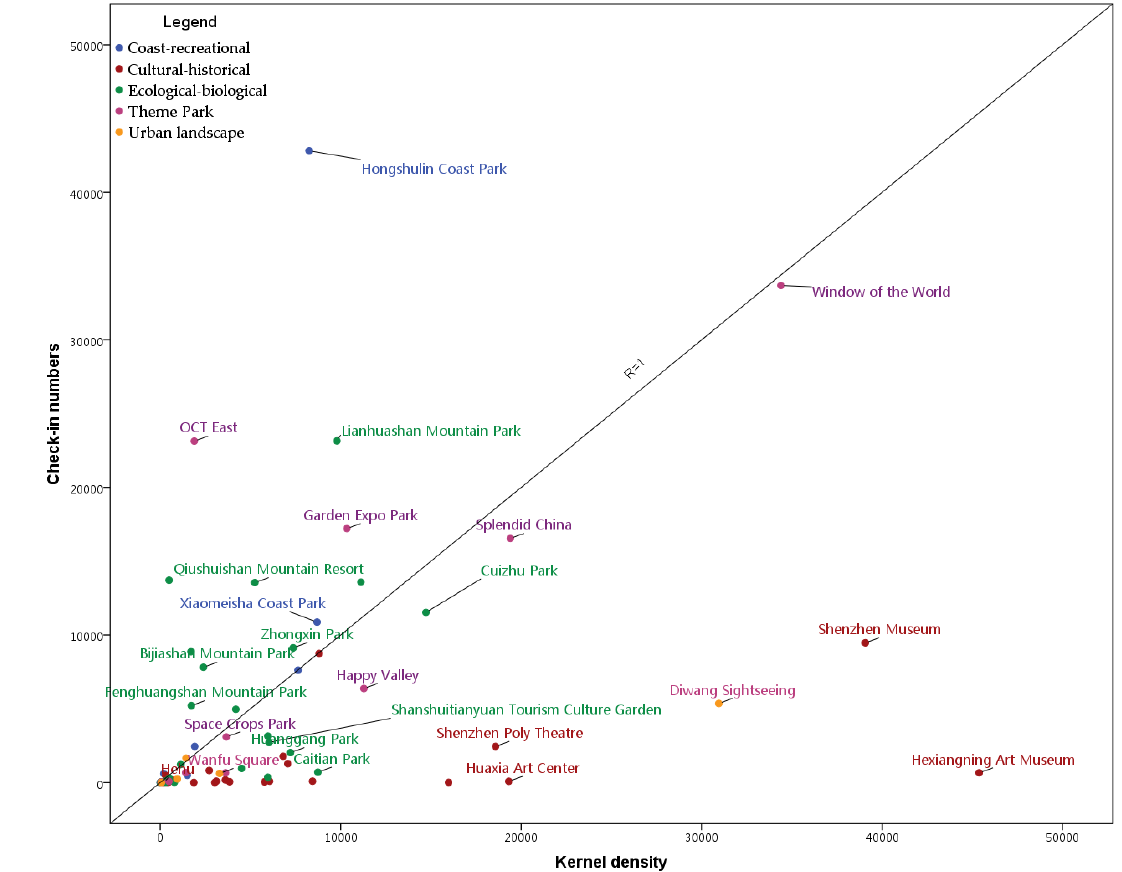
Figure 5. Activity kernel density of different users.